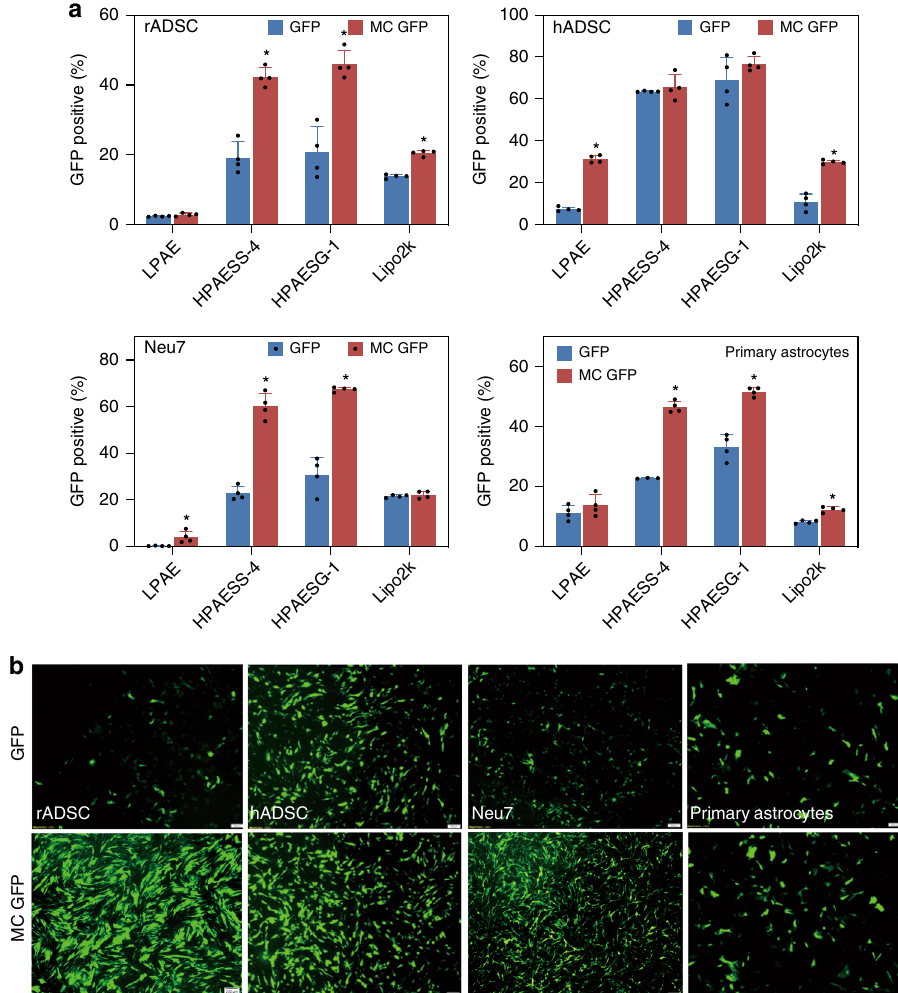
Fig. 8 MC DNA is superior to standard DNA in transfection of ADSCs and astrocytes. a , b HPAESG-1/MC GFP exhibits higher gene transfection ef fi ciency than HPAESG-1/GFP at the w / w ratio of 20:1. Data are shown as average ± SD; n = 4. Data points marked with asterisks (*) are statistically signi fi cant relative to the standard GFP group. The scale bars represent 200 μ